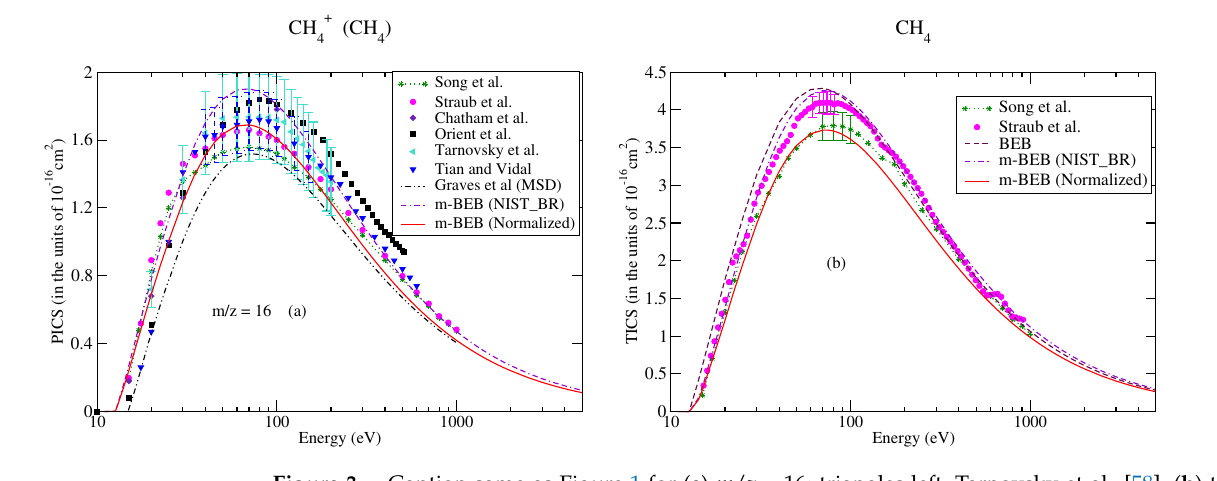
Figure 3. Caption same as Figure 1 for ( a ) m / z = 16; triangles left, Tarnovsky et al. [58], ( b ) total ionization cross-sections. Table 1. Branching ratios (BR) of various cations of methane produced by electron impact dissociation at 70